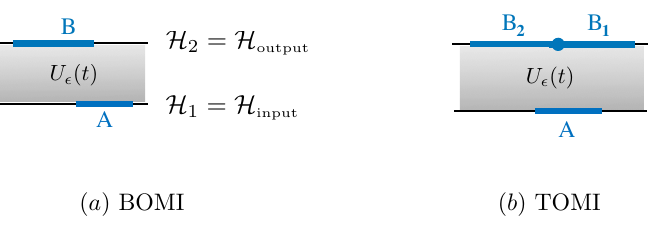
Figure 2 . General setup of operator mutual information. Hilbert spaces represented by the horizontal black lines. The subsystems are represented by the blue lines. The grey area in between the two Hilbert spaces indicates time evolution dictated by U (cid:15) ( t ), with the arrow of time t pointing from case. For TOMI, we generally take B 1 and B 2 to be a bipartition of the entire output Hilbert